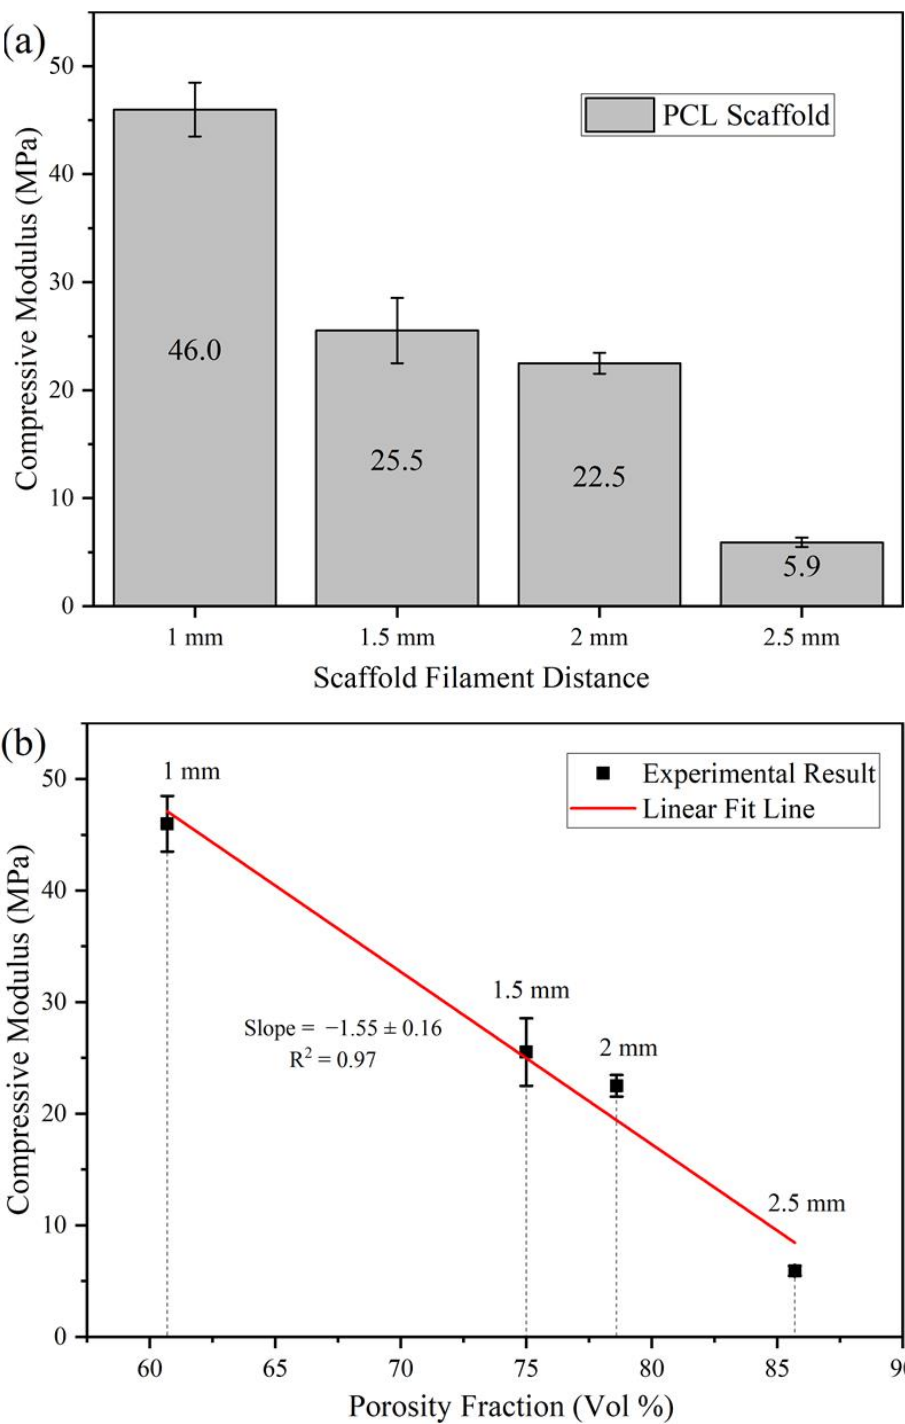
Figure 7. Experimentally obtained compressive modulus. ( a ) Compressive modulus of printed scaffolds considering different filament distances (N = 4). ( b ) The correlation between compressive modulus and the scaffold designed porosity.